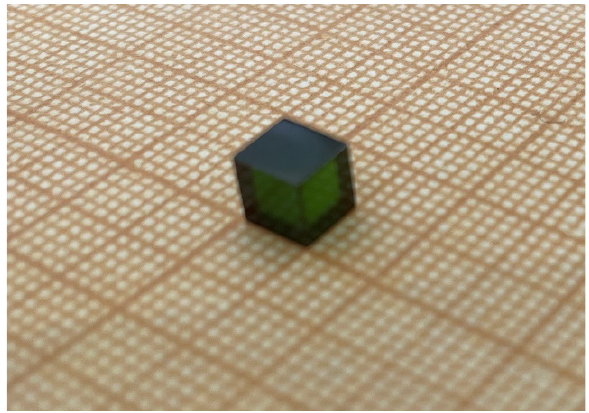
Figure 1. Image of the studied crystal LiTaO 3 :Cr(0.2):Nd(0.45 wt%). Table 1. Impurity composition of the initial LT charge and LiTaO 3 :Cr(0.2):Nd(0.45 wt%) crystal.